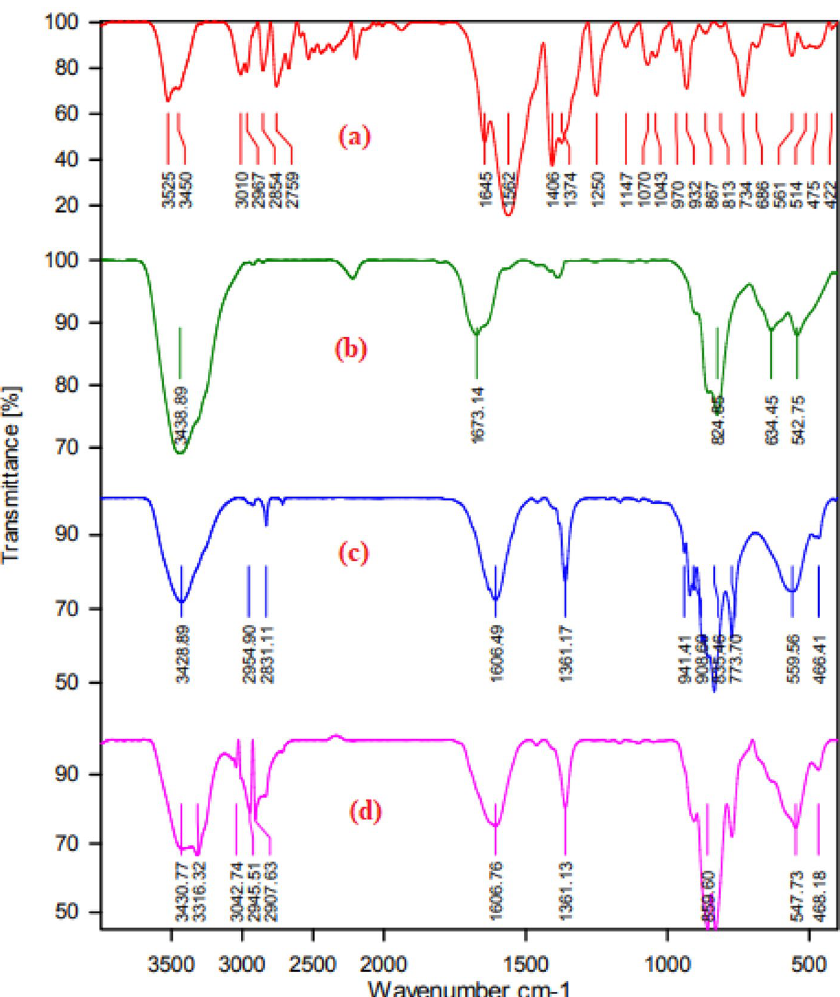
Figure 2. FT-IR spectra of 4-piperidinecarboxylic acid (a) Na 2 MoO 4 ·2H 2 O (b) Mo-based metal organic framework, before recovery (c) Mo-based metal organic framework, after recovery (d).